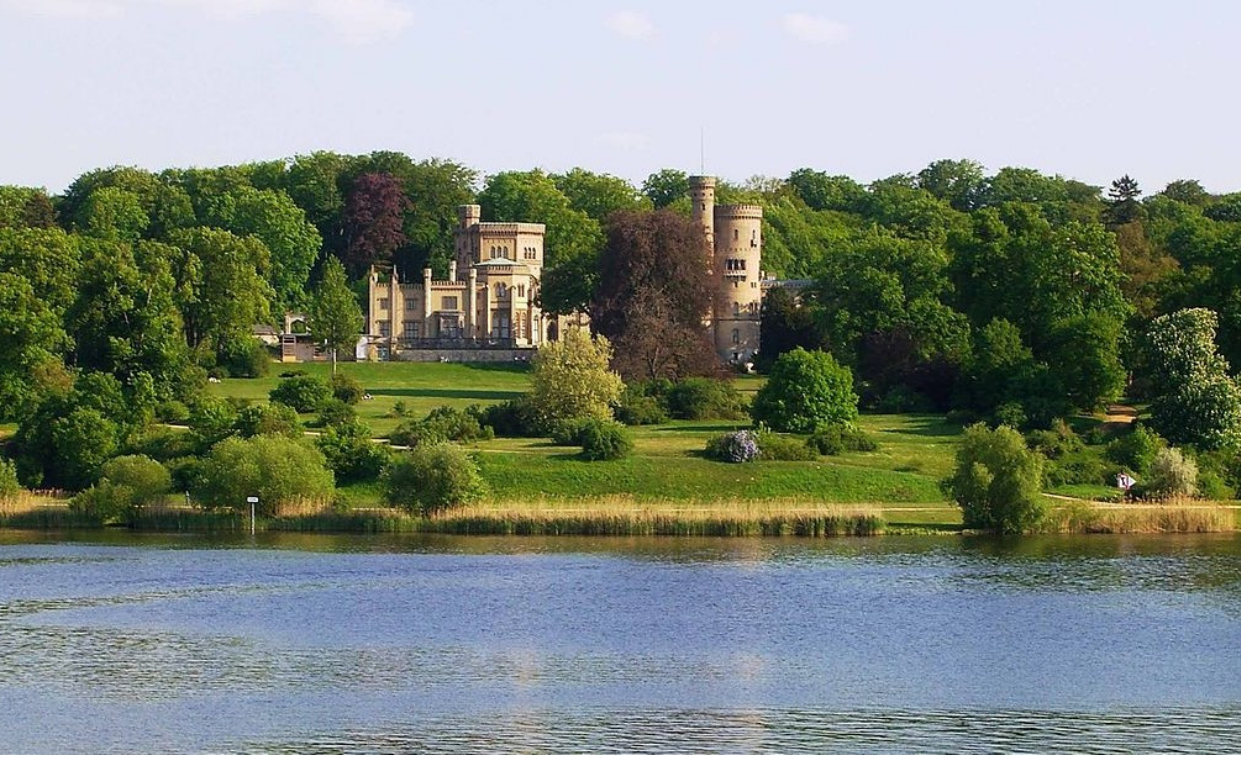
Figure 5. View of the romantic, landscaped Babelsberg Castle, the imperial summer residence, designed by K. F. Schinkel in 1843. The most probable inspiration for the complex palace and park development in Maciejewo. Source: (Babelsberg Castle 2006).